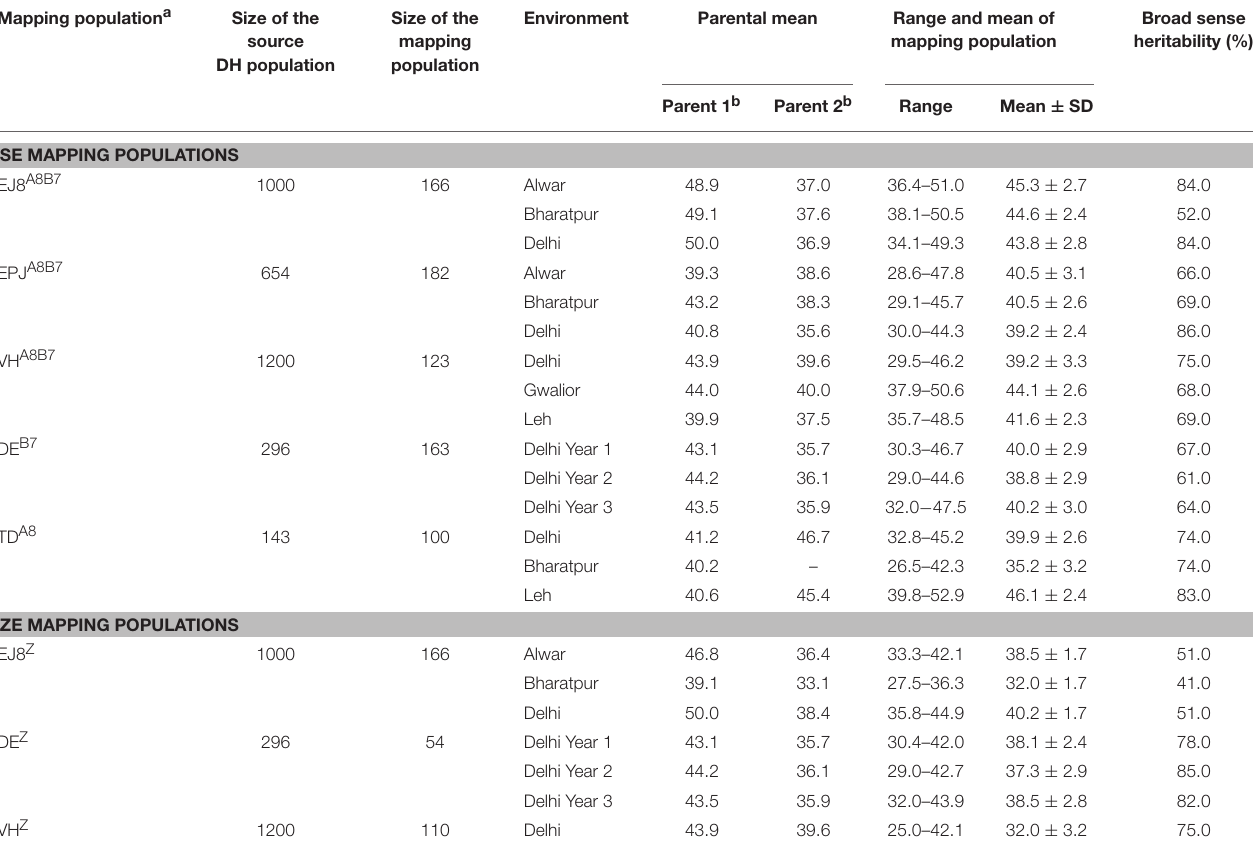
TABLE 2 | Phenotypic performance of the parents and eight bi-parental mapping populations of B. juncea for seed oil content at different locations. Mapping population a